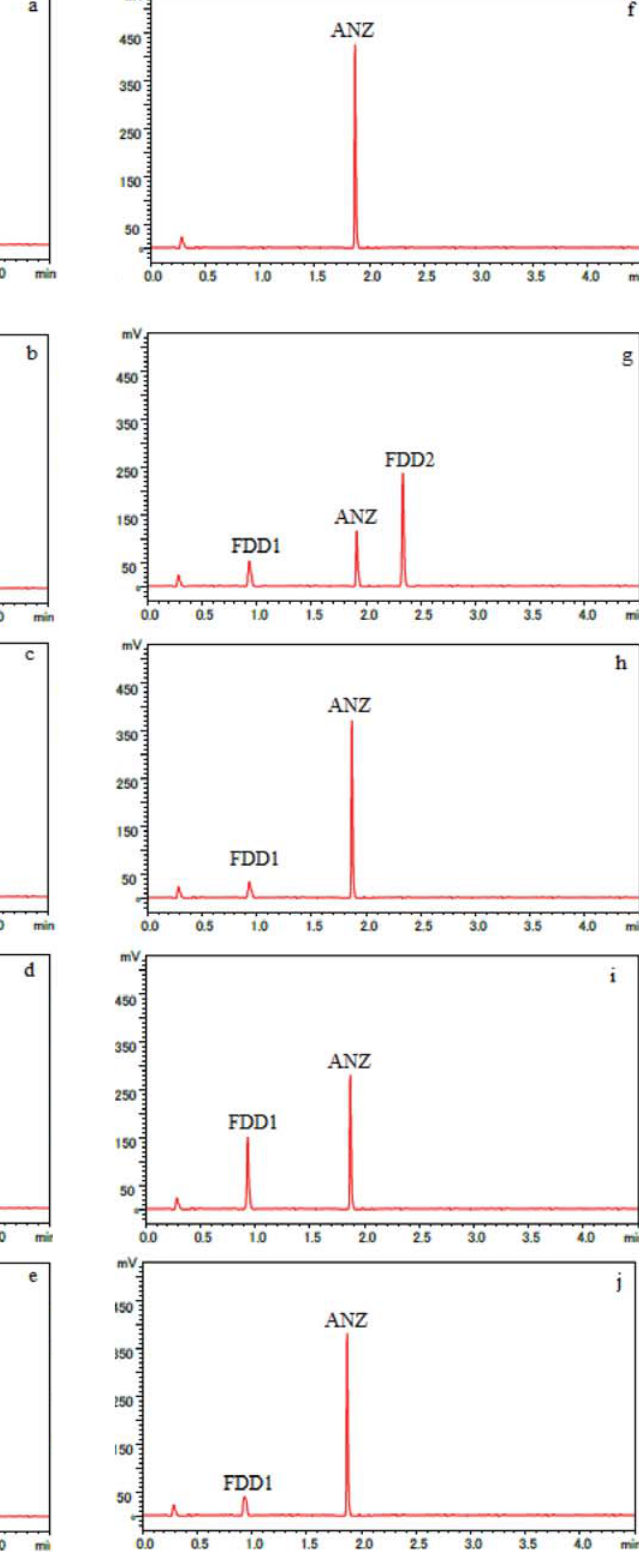
Ali et al.: Stability Indicating UHPLC-PDA Assay ...